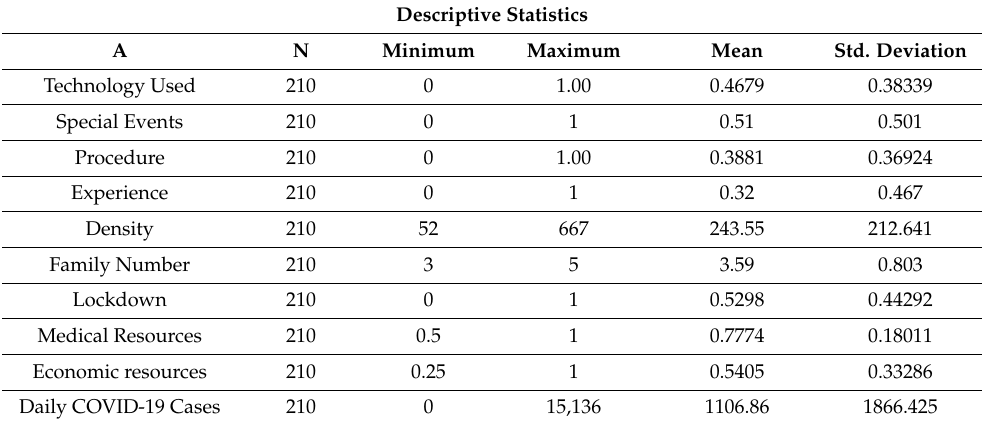
Table 2. Summary statistics for the variables used in path analysis.